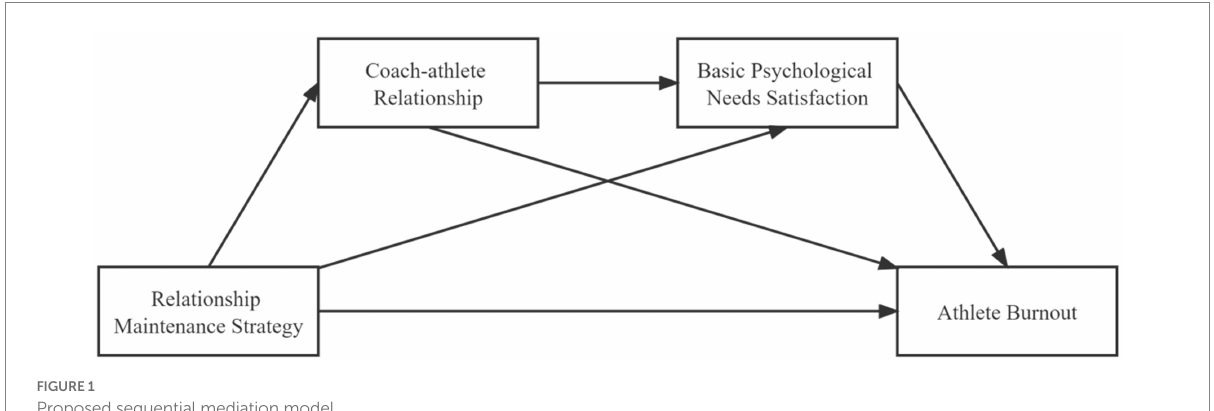
FIGURE 1 Proposed sequential mediation